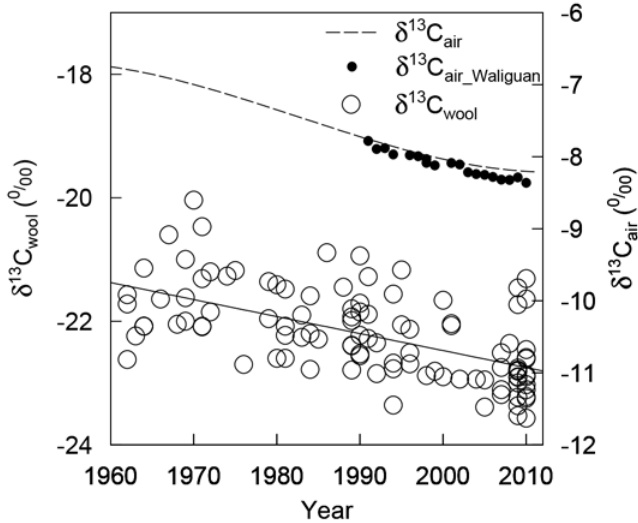
Fig 2. Carbon isotopic composition of wool ( δ 13 C wool ) from Tibetan alpine meadows and of atmospheric CO 2 ( δ 13 C air, δ 13 C air_Waliguan ). The wool data were fitted with a linear model (y = – 0.028x + 32.561, n = 106, P < 0.001).